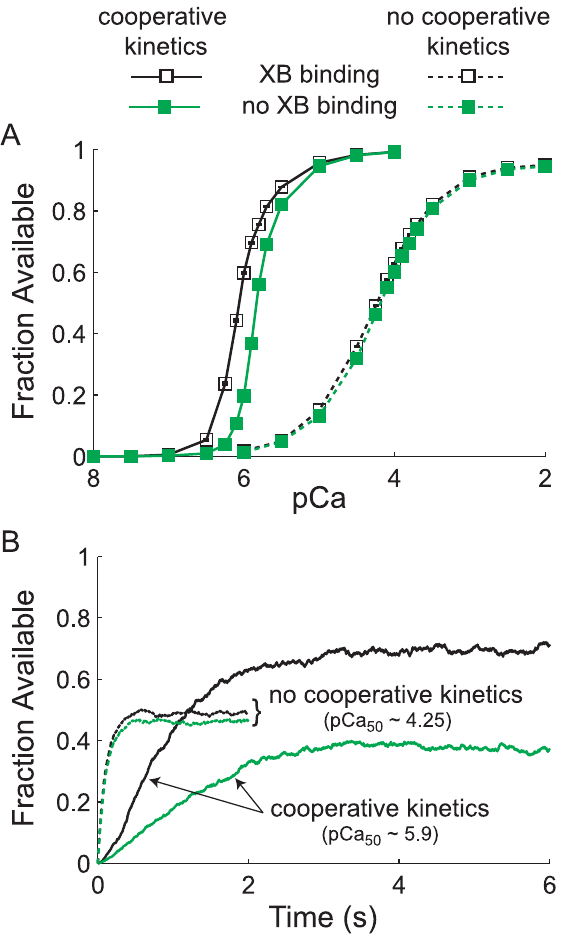
Figure 4. Cross-bridge (XB) binding stabilizes and augments thin filament activation. (A) Steady-state thin filament activation is plotted against pCa for simulations where standard parameter values were applied (see Figure 3), in the presence and absence of kinetic forms of cooperativity. XBs produce larger increases in fractional thin filament activation when cooperative kinetics were present, evidenced by the increase in activation in the presence versus absence of XB binding. These XB-dependent increase in thin filament activation are greatest at submaximal pCa levels, shown by the differences between the two curves when kinetic forms of cooperativity were implemented. Symbols represent mean 6 SE, where error bars reside within the symbol when not visible. (B) Average thin filament activation is plotted against time for simulations near the pCa 50 value of the steady-state force-pCa response (Figure 3), with (pCa=5.9) and without (pCa 4.25) kinetic forms of cooperativity. These time series activation traces demonstrate the representative slowing of thin filament activation kinetics and increased magnitude of thin filament activation due to XBs in the presence of cooperativity. All simulations used standard parameter values: r Tn =1, k xb =3 pN nm 2 1 , k fil = k m = k a =1X, and RU span =9 actins.